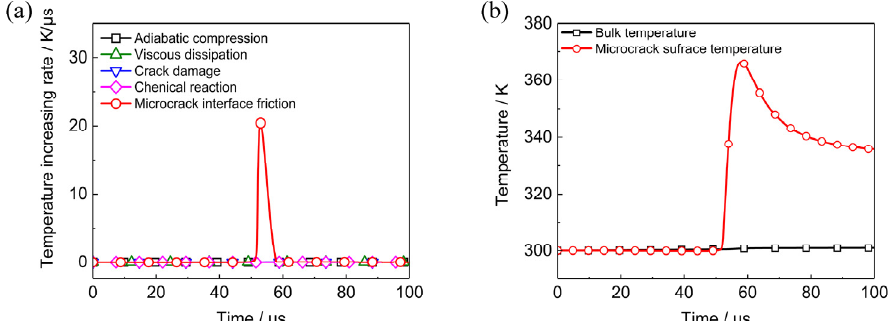
Figure 7. Temperature increasing rates due to different mechanisms and the resulting evolutions of representative element volume (RVE) bulk temperatures and microcrack surface temperature when PBX1314 is under dynamic uniaxial compression and at the strain rate of 2000 s − 1 . ( a ) Temperature increasing rates due to five different mechanisms, ( b ) RVE bulk temperature and microcrack surface temperature.